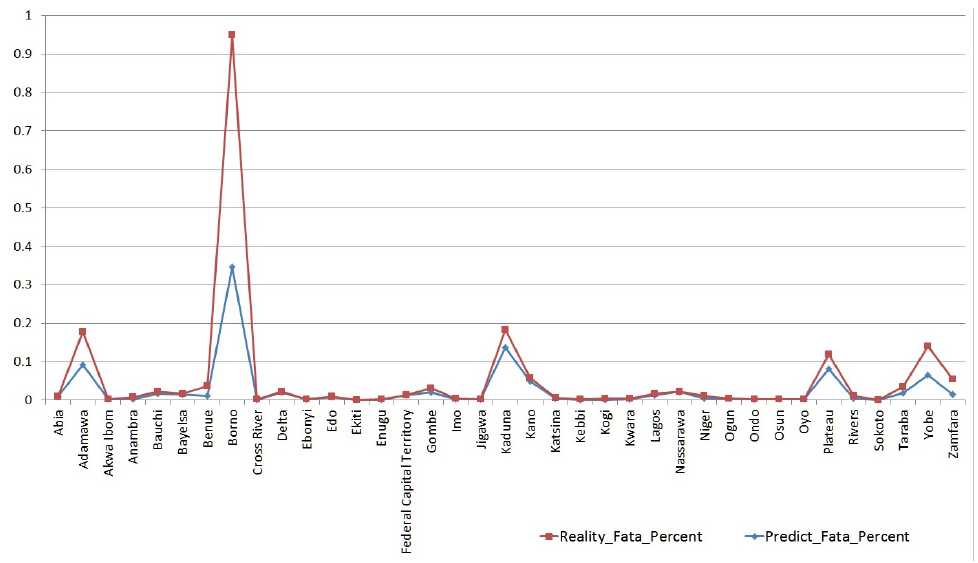
Figure 12. Comparison between the ratios of the issued